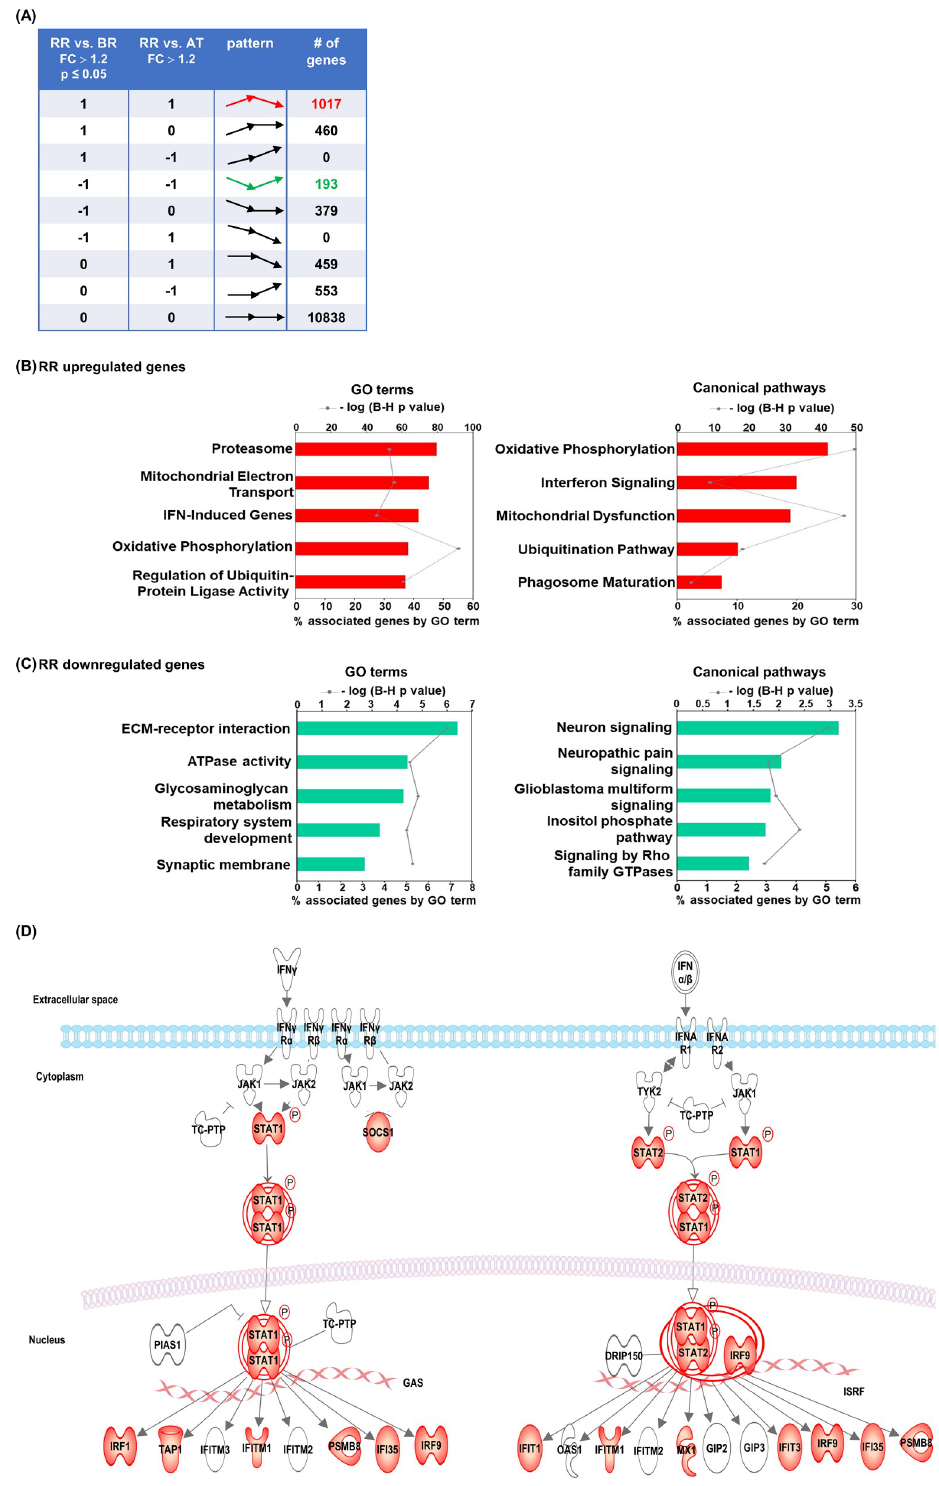
Fig 1. Functional analysis of differentially regulated genes. (A) For differential gene expression between RR, BR and AT whole blood samples we calculated fold change analysis and performed a paired statistical test using DEseq2. A cut of fold change � 1.2 and p � 0.05 was applied for RR vs. BR and fold change � 1.2 was applied for RR vs. AT. In examining the RR temporal stages: BR (before reaction); RR (reversal reaction), AT (after treatment), we identified